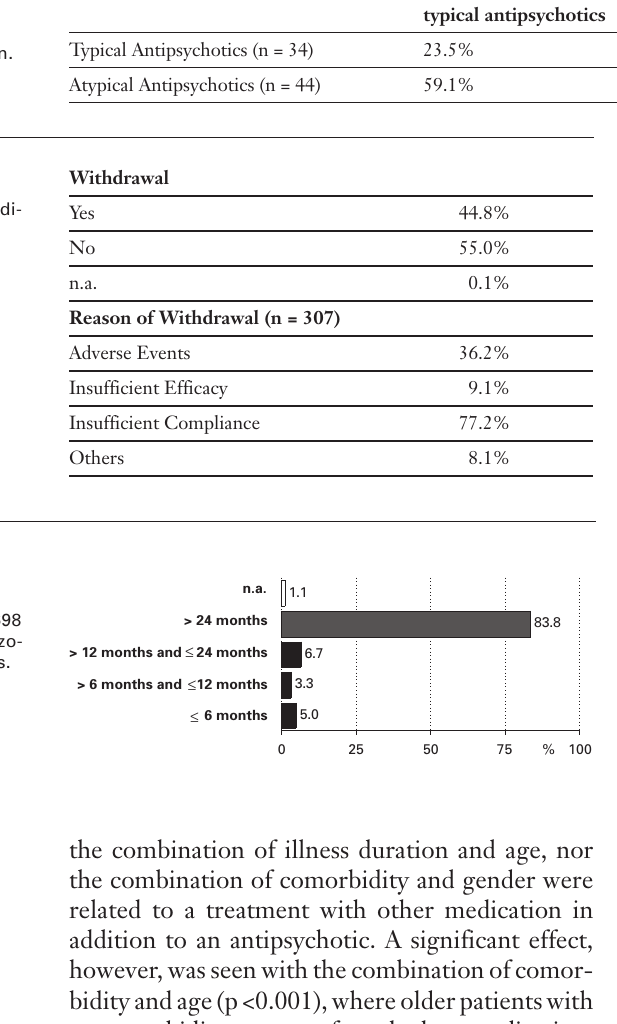
Medication In combination with Polypharmacy: Combination with 1 other medication.